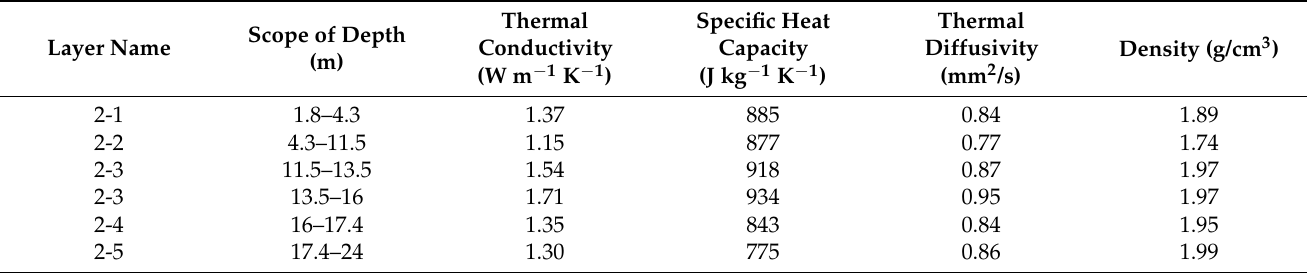
Table 2. Thermophysical indexes of each soil layer.